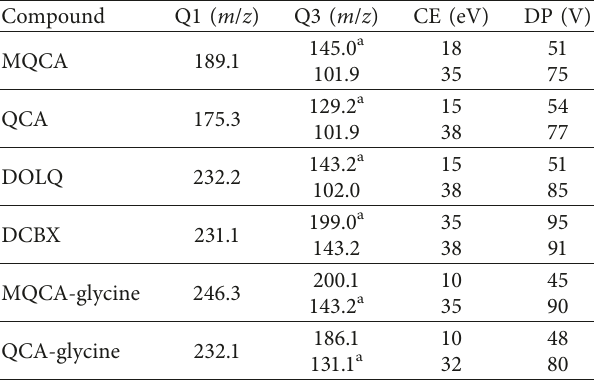
a The most abundant ion (also used for